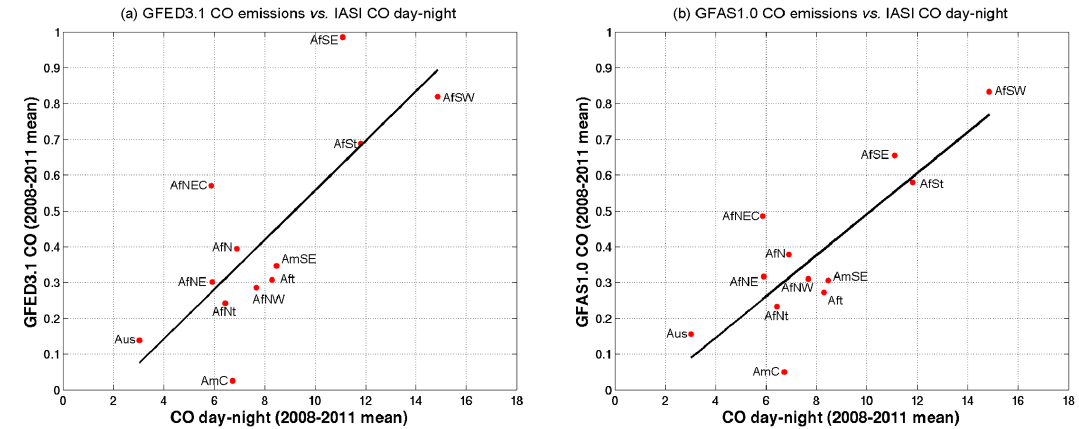
Figure 8. (a) GFED3.1 and (b) GFAS1.0 emissions (in gCOm − 2 ) as a function of the day–night difference of the integrated content of CO from IASI (inppbv) in different tropical areas (see Fig. 7), on average over 2008–2011.